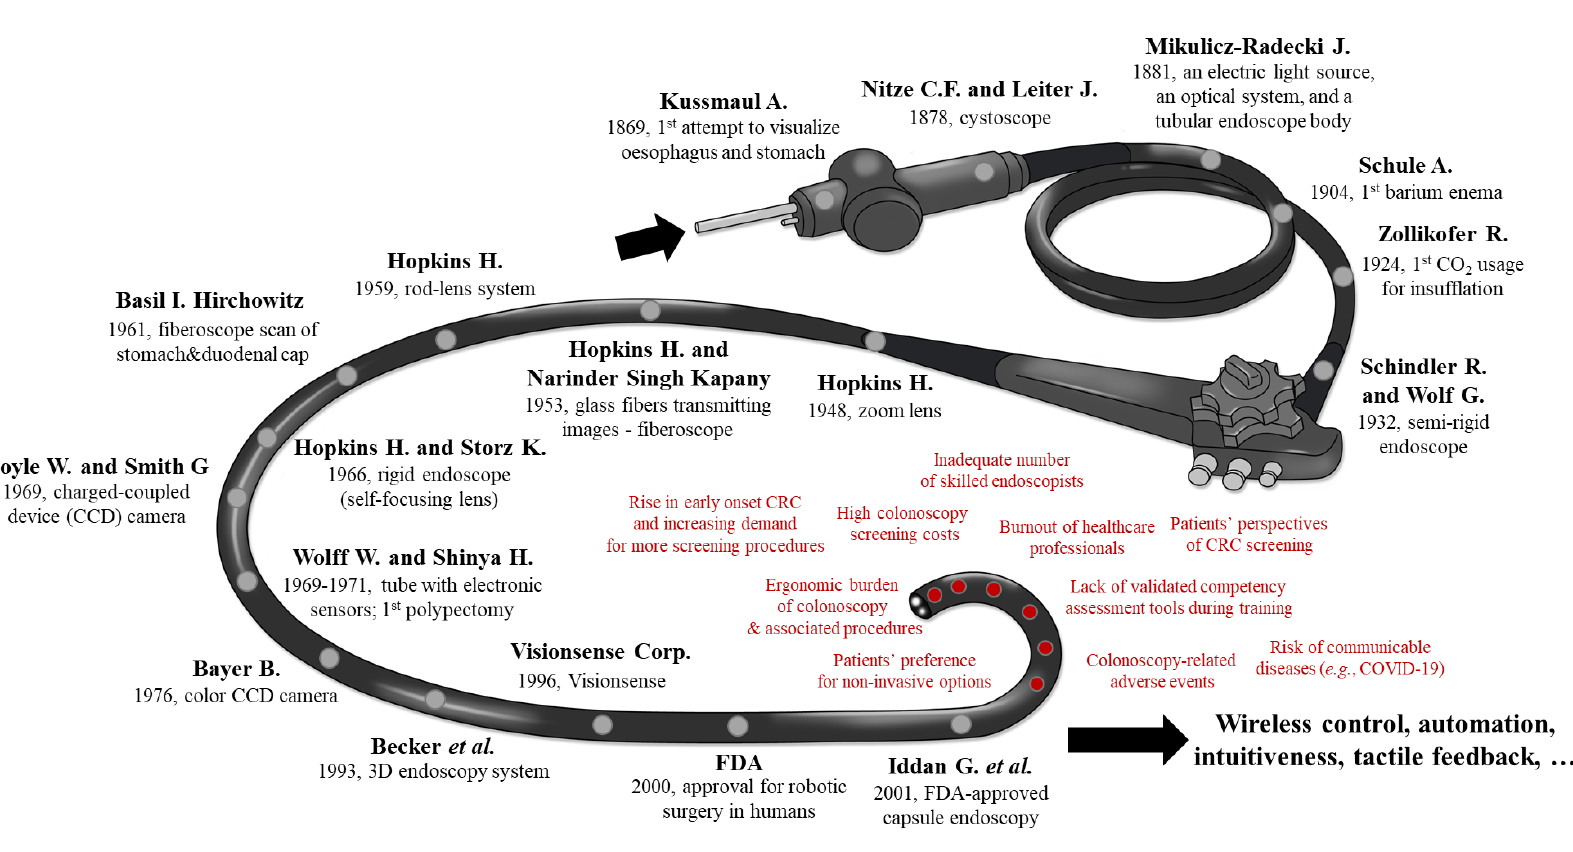
Figure 1. Graphical representation of all the key milestones in colonoscopy (black text) and possible factors impeding future high-throughput colonoscopy screening programs (red text).